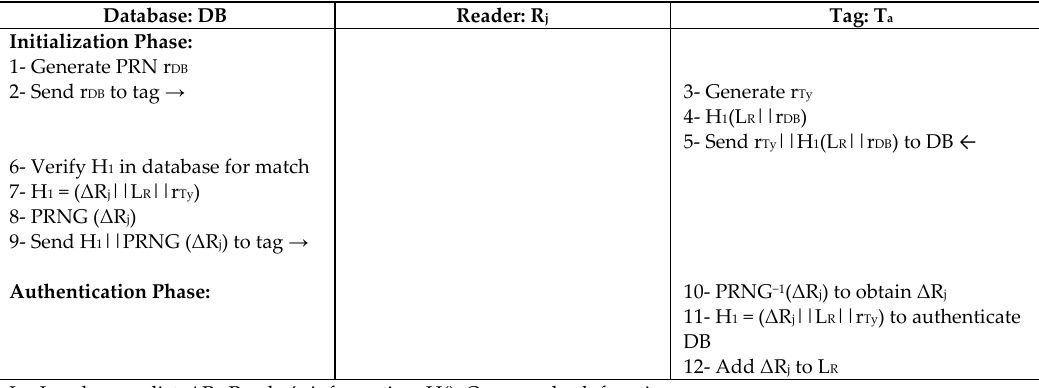
Figure 14. Desynchronization Attack-Resistant Robust Authentication Protocol (DRAP) by Rahman and Ahamad.